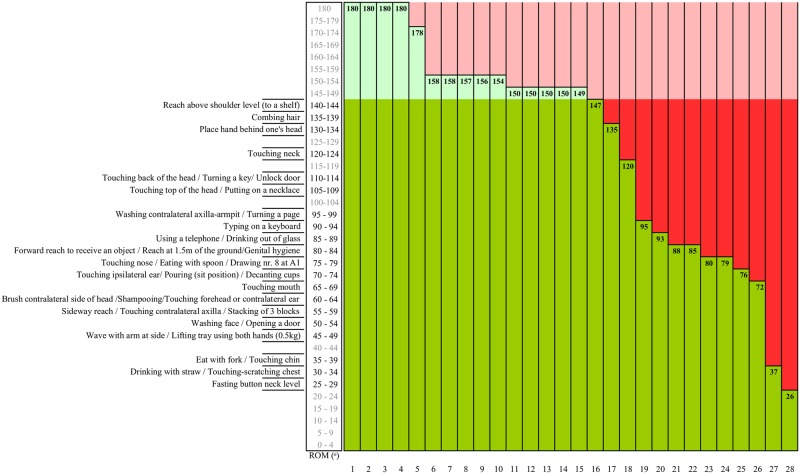
Schematic illustration of activities of daily life (ADL) that can (dark green) or cannot (dark red) be performed after burn injury in the shoulder joint area, based on measured Range of Motion (ROM) of 28 shoulders 3 month post burn (ROM given in bold numbers) and the required shoulder flexion ROM for 36 different ADL tasks as synthesized by Oosterwijk et al. [29–30].Light green and light red represent joint angles that can or cannot be performed, respectively, but do not affect functionality based on the included tasks. Note that not many of the tasks need near full (145°-180°) shoulder flexion ROM meaning that up to 35° ROM deficit might have rather limited impact on daily functioning.